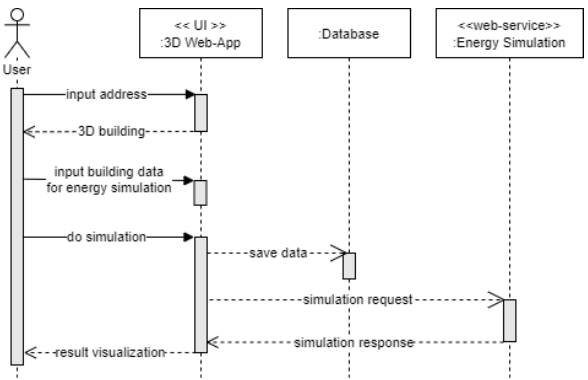
Figure 2. Data collection sequence